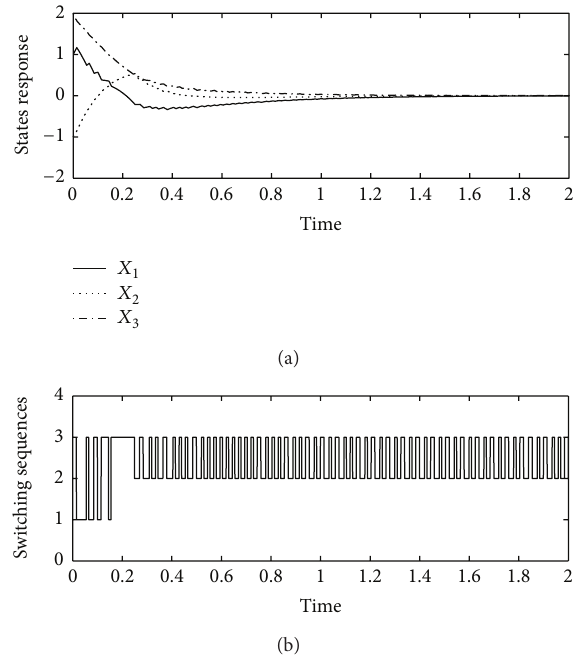
Figure 2: (a) Timing response of the three states and (b) switching